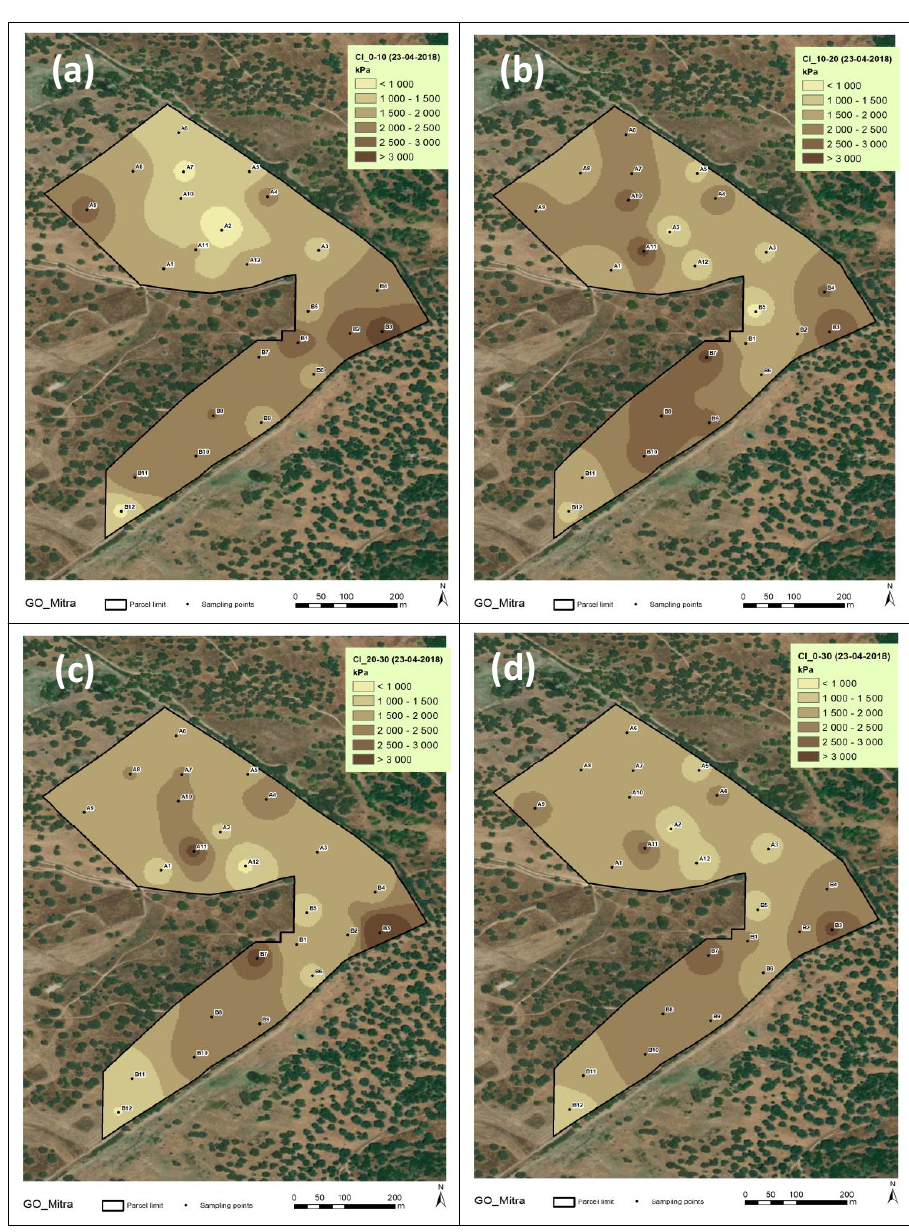
Figure 11. Cone Index (CI) maps of the experimental field in April 2018: ( a ) 0 – 0.10 m; ( b ) (0.10 – 0.20 m; ( c ) 0.20 – 0.30 m; ( d ) 0 – 0.30 m.